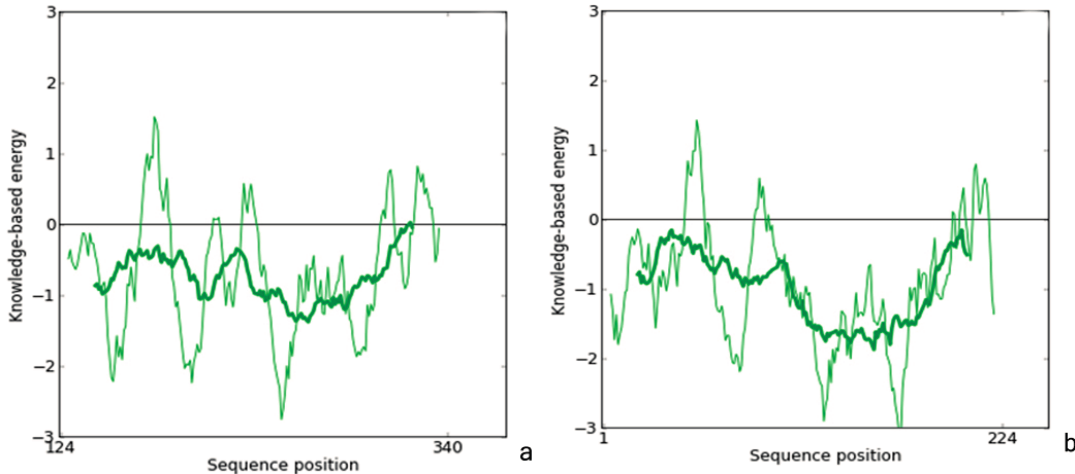
Figure 3. Screen shot of residue of a native protein ( a ) zmCP1; ( b ) PDB ID 1S4V. Thin line represents result of window size 10, thick line represents result of window size 40.